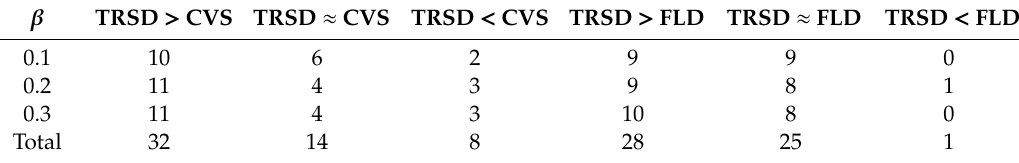
Table 5. Dunn’s test results in di ff erent β for the significant level α = 0.05.